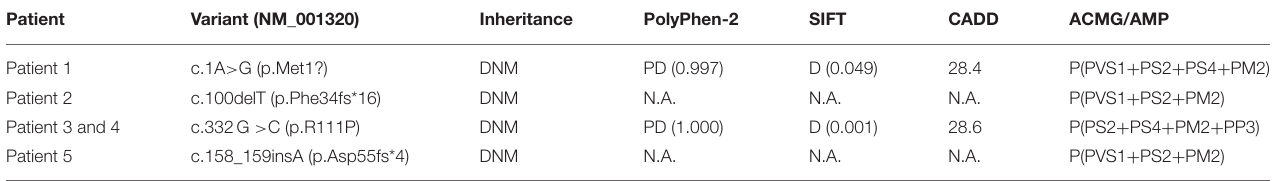
TABLE 2 | Predicted pathogenicity of de novo CSNK2B